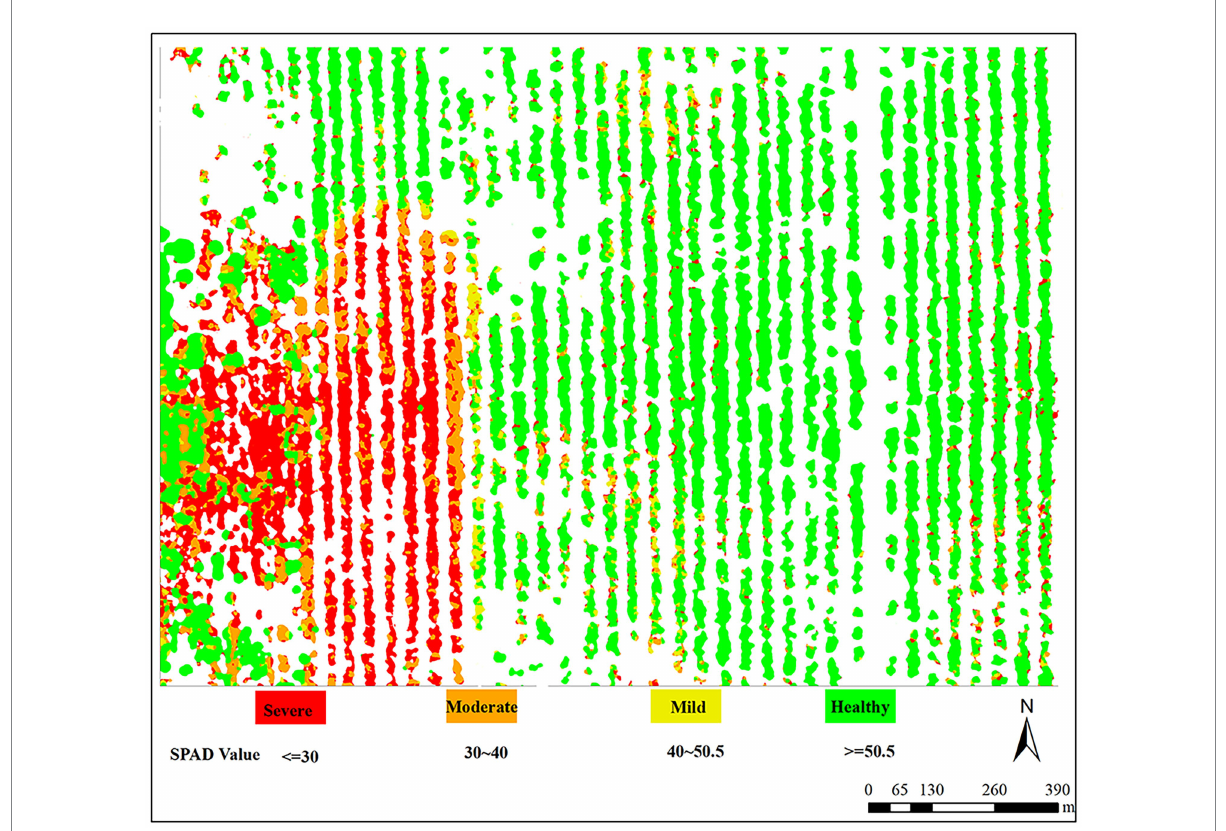
FIGURE 10 Inversion spatial distribution map of infestation severity of jujube